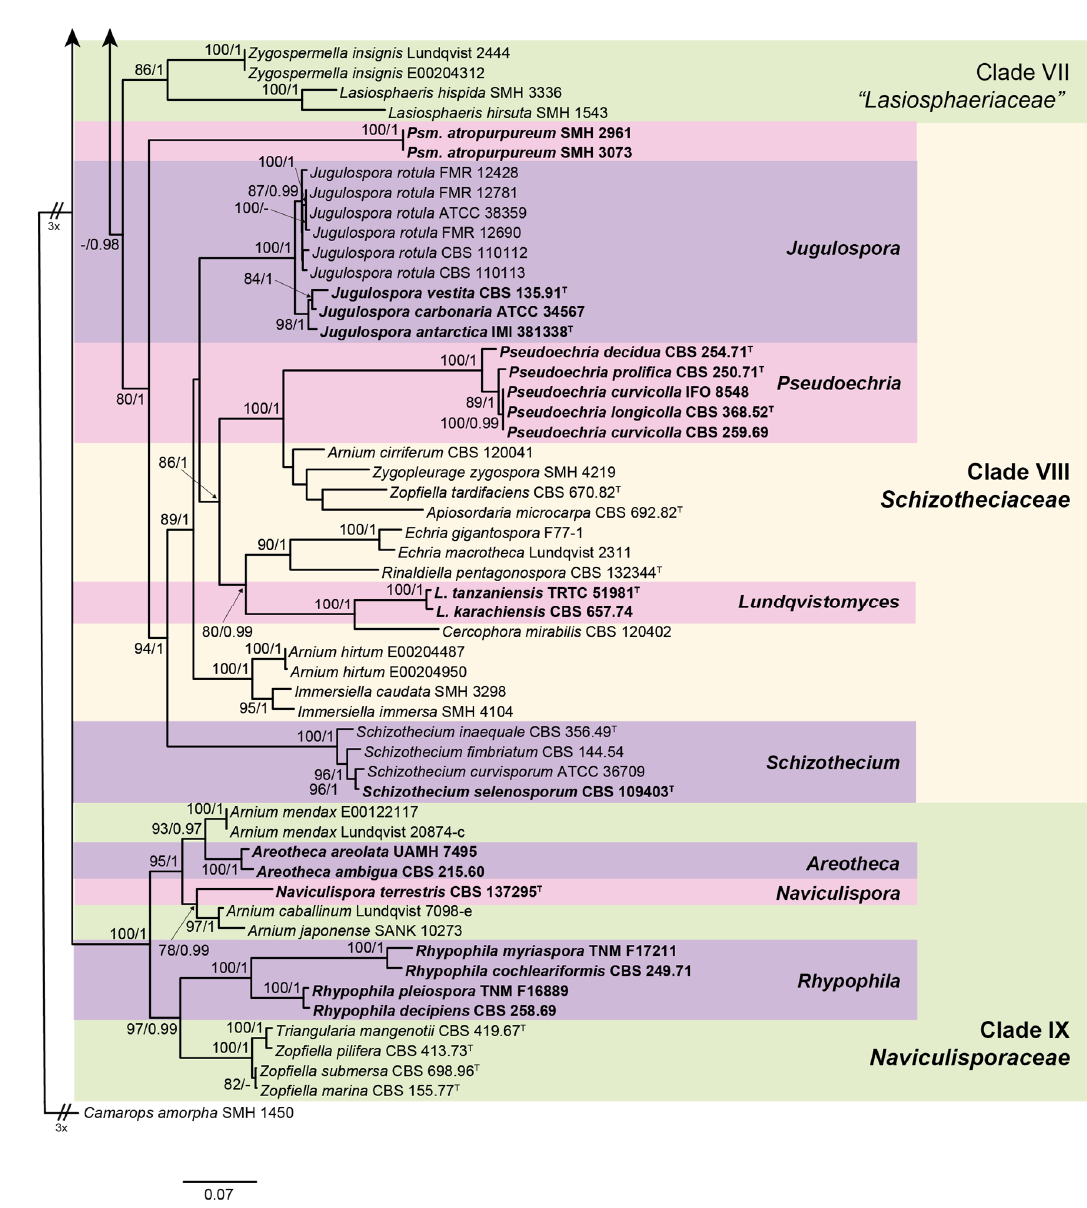
Figure 2 . Second part of the RAxML phylogram obtained from the combined ITS, LSU, rpb2 , and tub2 sequences of our isolates and selected strains belonging to the families Chaetomiaceae, Diplogelasinosporaceae, Lasiosphaeriaceae, Naviculisporaceae, Podosporaceae, Schizotheciaceae, and Sordariaceae. Camarops amorpha was used as an outgroup. Bootstrap support values ≥70/Bayesian posterior probability scores ≥0.95 are indicated along branches. Branch lengths are proportional to distance. Novelties and emended taxa are indicated in bold . Ex-epitype, ex-isotype, and ex-type strains of the different species are indicated with ET , IsoT , and T , respectively.